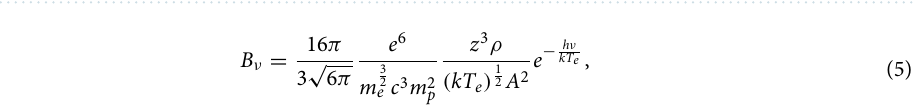
Figure 6. (Color online) ( a ) One-dimensional average distribution of the core area emission extracted from Fig. 4(d) (red curve). Purple curve is the obtained Gaussian function curve. Upper right curve is the first derivative of the 1D average distributions. ( b ) Abbe inversion results of the core emission